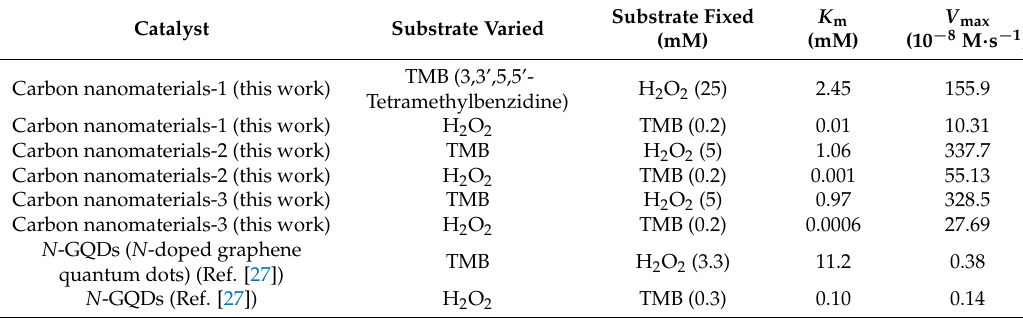
Table 1. Michaelis-Menten constant ( K m ) and maximum reaction rate ( V max ) of different carbon nanomaterials in this work and